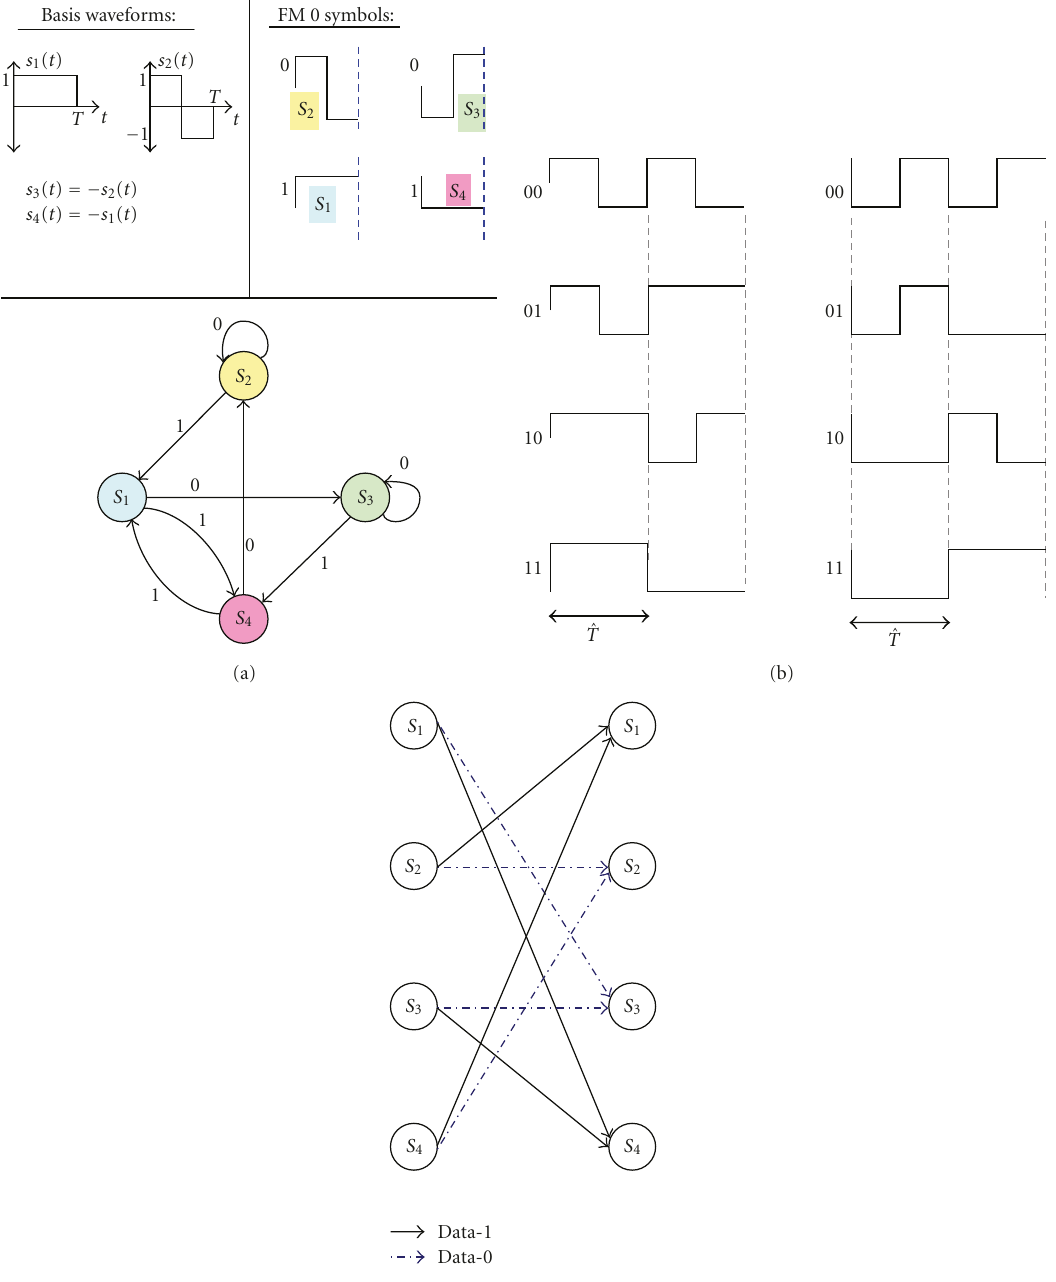
Figure 2: (a) The basis functions and the state diagram of the FM0 baseband data-encoding scheme. (b) Examples of FM0 baseband signals for two-bit data sequences. (c) The trellis representation of the FM0 data encoding scheme.